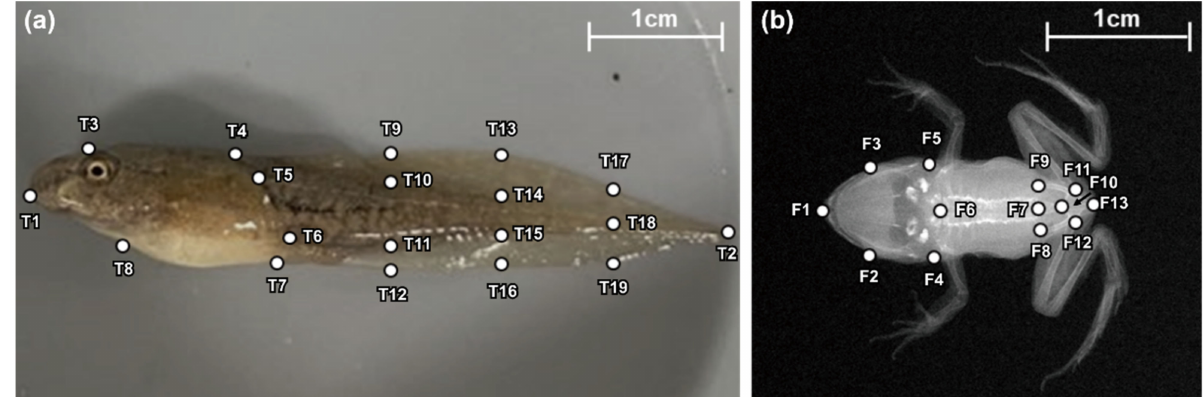
Figure 3. Left-side image of a tadpole, as well as the X-ray bone image of a juvenile frog. ( a ) Nineteen landmark points were designated to represent the body and tail shapes of the tadpole, as well as to compare the morphological difference between the predation and control groups. ( b ) Thirteen landmark points were assigned in order to quantify and compare the skeletal morphology of the head and lower body in juvenile